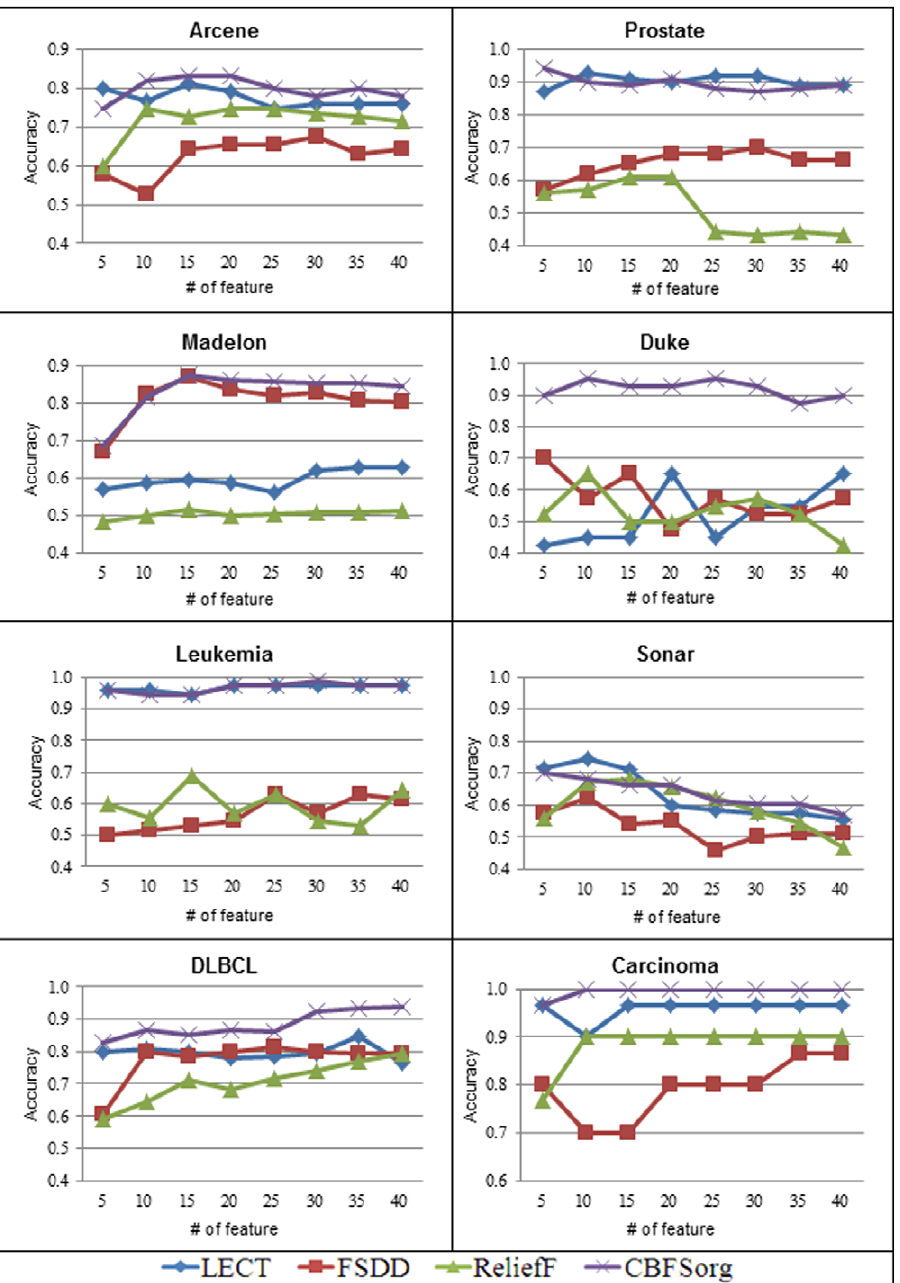
Figure 5. Comparison of classification accuracy using KNN where K=5. In every case, CBFSorg shows best classification accuracy.